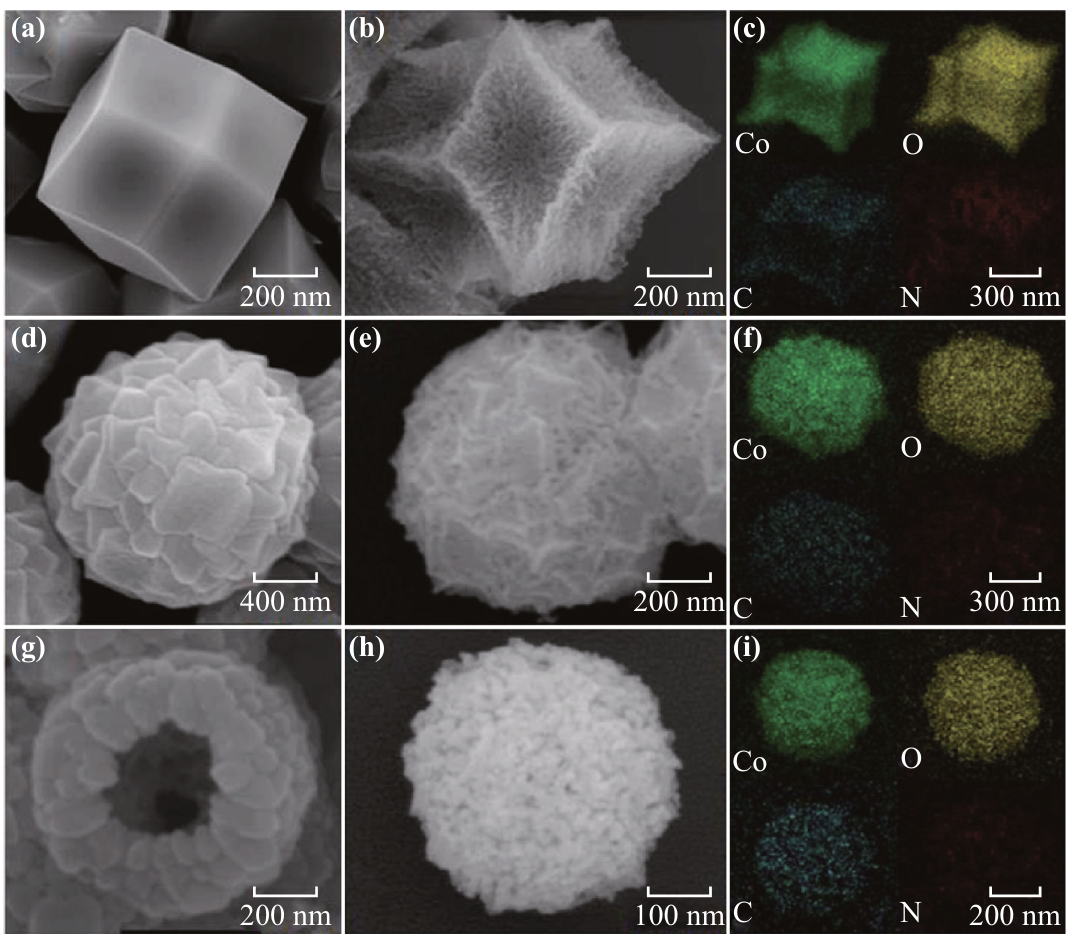
Fig. 1 SEM images of a T-ZIF-67, b T-Co 3 O 4 /NPC , d M-ZIF-67, e M-Co 3 O 4 /NPC , g H-ZIF-67, and h H-Co 3 O 4 /NPC. Elemental mapping of c T-Co 3 O 4 /NPC, f M-Co 3 O 4 /NPC, and i H-Co 3 O 4